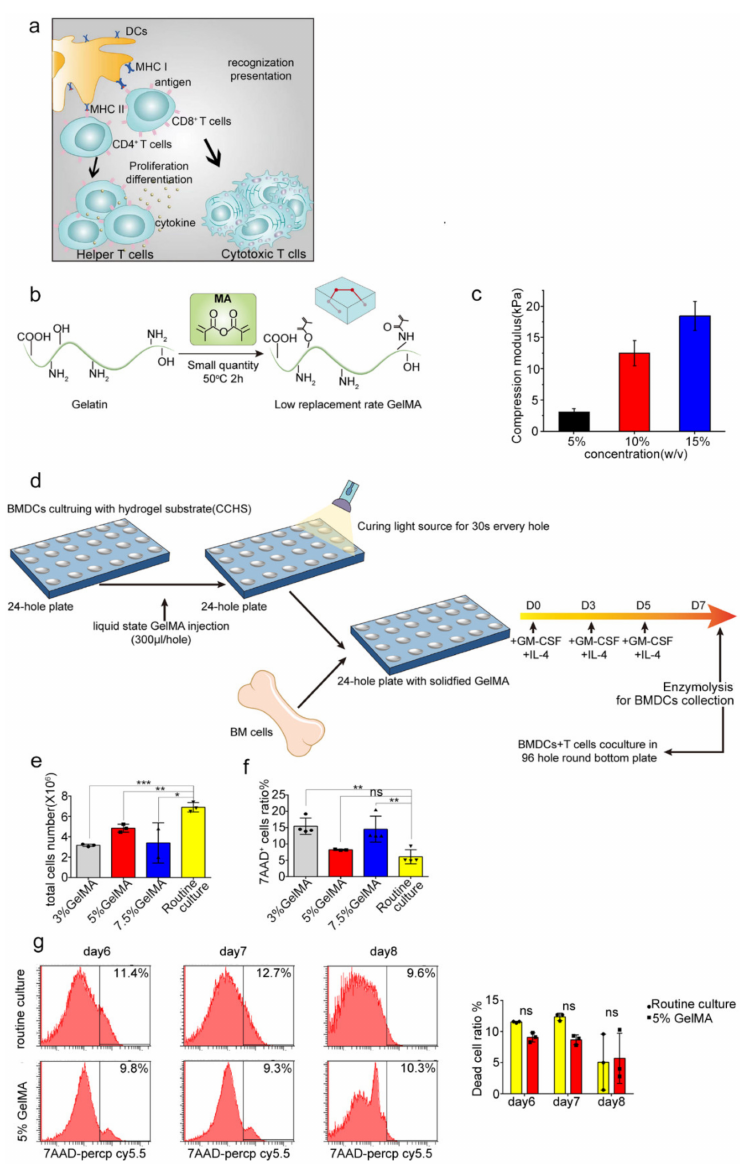
Figure 1. BMDCs on GelMA-30 substrates. ( a ) The interaction between DCs and T cells. ( b ) Synthetic equation of GelMA-30 hydrogels with low substitution rate. ( c ) The table about the